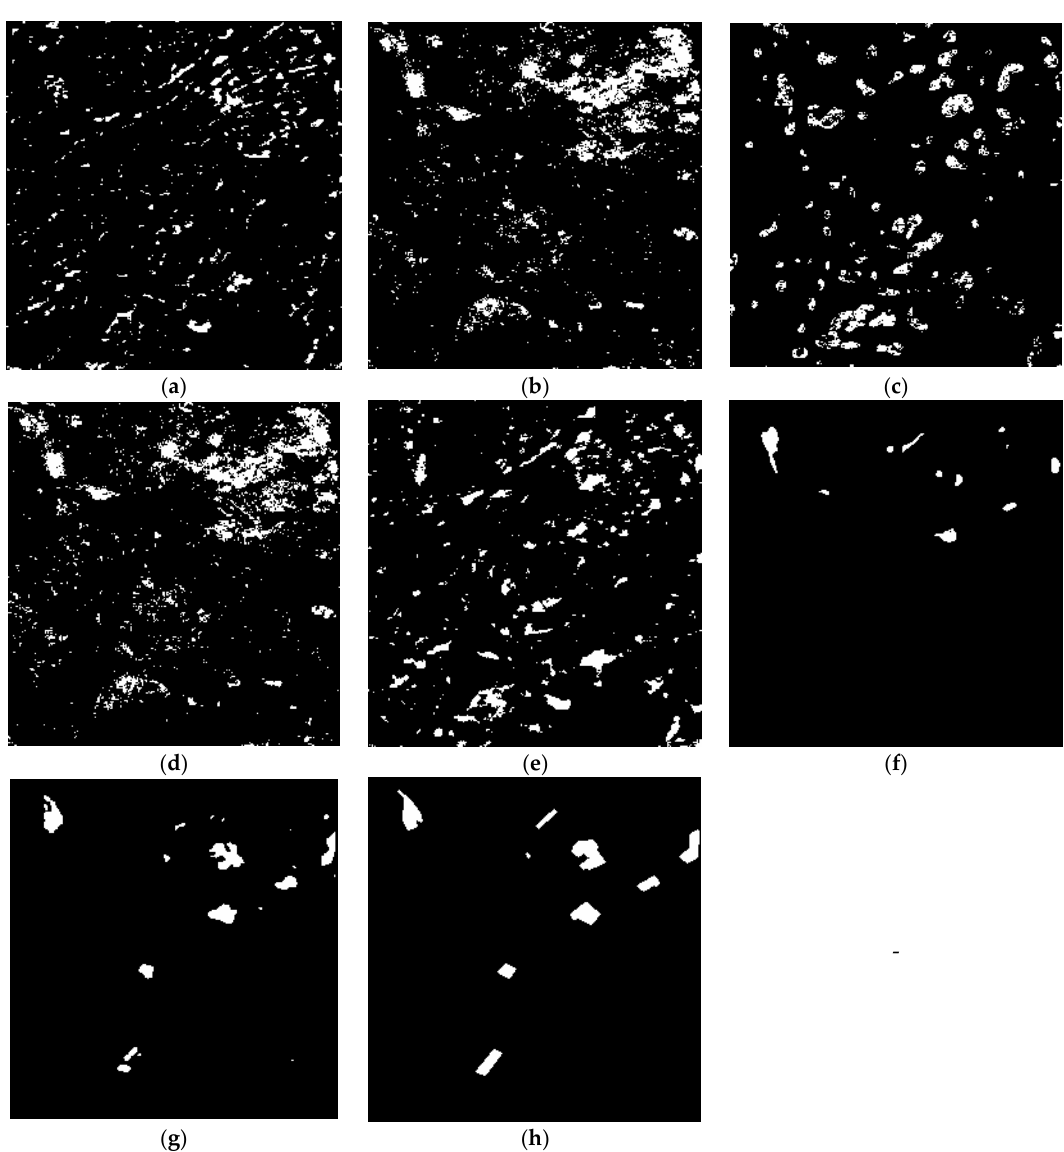
Figure 12. The change detection maps produced by different methods for the Multispectral-Saclay dataset. ( a ) CVA-SVM, ( b ) MAD-SVM, ( c ) PCA-SVM, ( d ) IR-MAD -SVM, ( e ) SFA-SVM, ( f ) 3D-CNN, ( g ) Proposed Method, and ( h ) Ground Truth. White and black colors indicate the change and no-change areas, respectively.